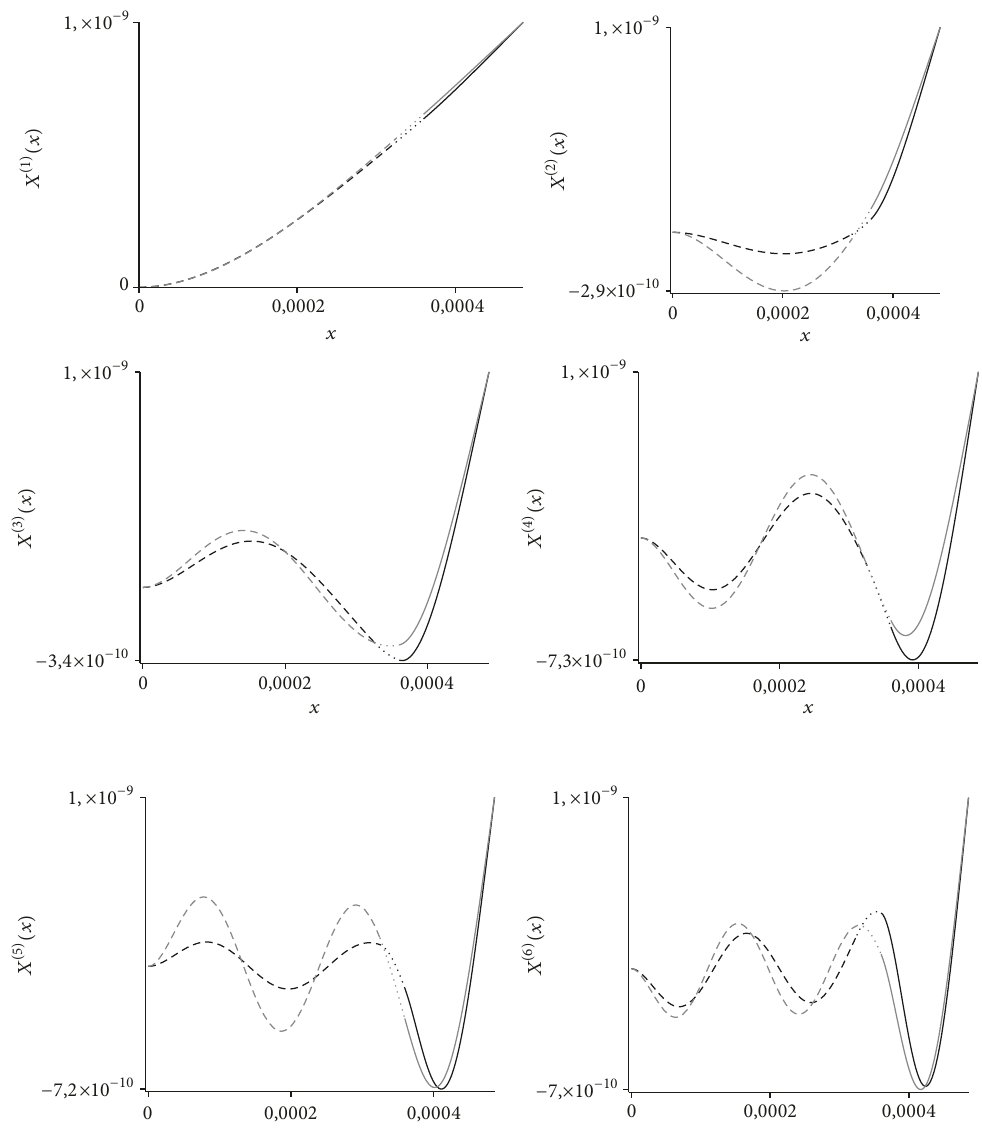
Figure 2: First six beam vibration modes: beam with piezoelectric layer (black line); beam (gray line) 1st segment (dash) [0,𝑙 1 ] , 𝑙 1 = 325 × 10 −6 𝑚 ; 2nd segment (dot) [𝑙